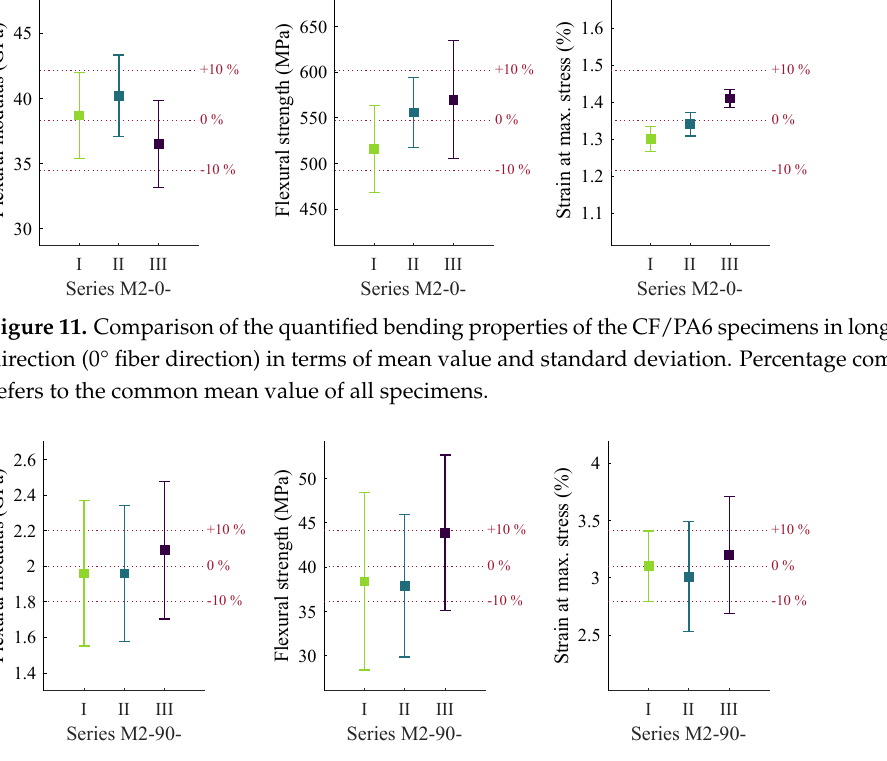
Figure 12. Comparison of the quantified bending properties of the CF/PA6 specimens in transverse direction (90° fiber direction) in terms of mean value and standard deviation. Percentage comparison refers to the common mean value of all